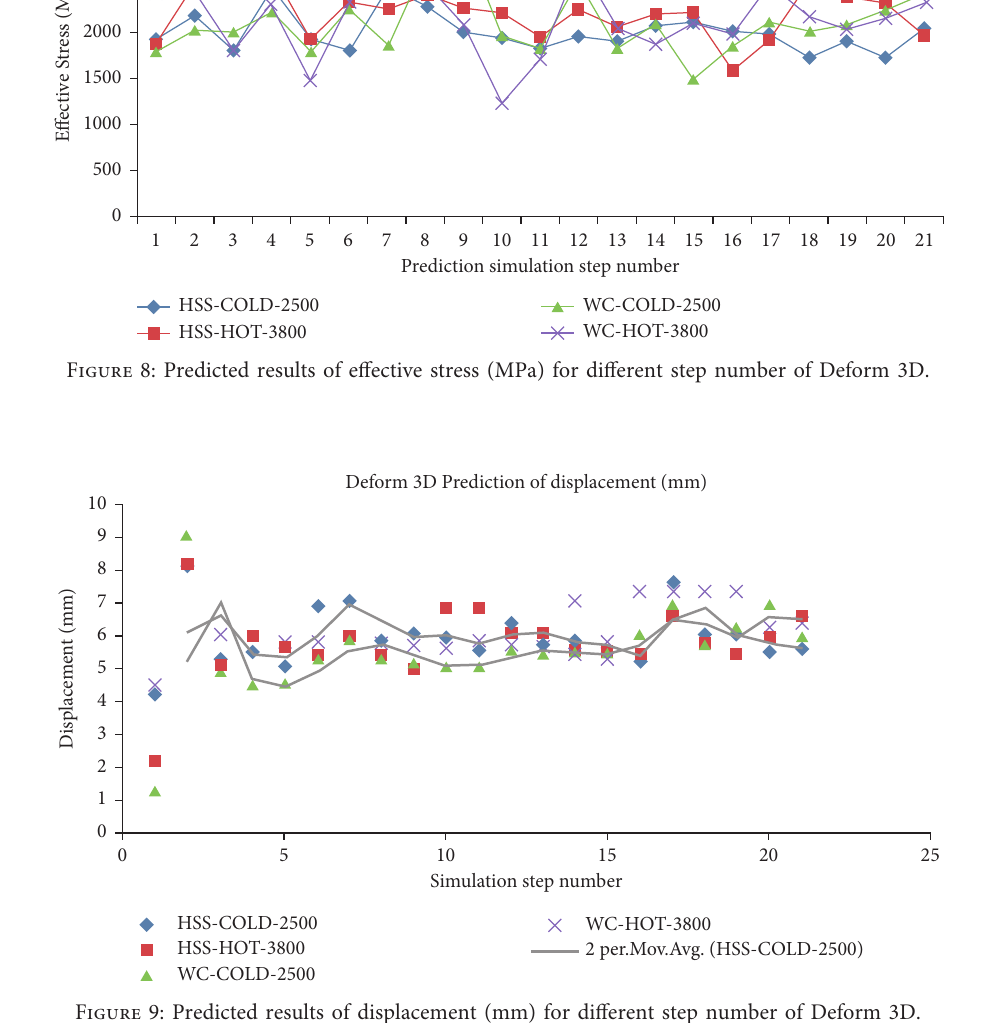
Figure 9: Predicted results of displacement (mm) for different step number of Deform